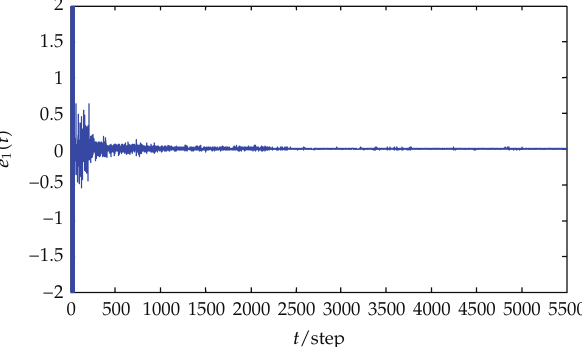
(cid:5) II (cid:6) s (cid:5) t | t (cid:6) . 2